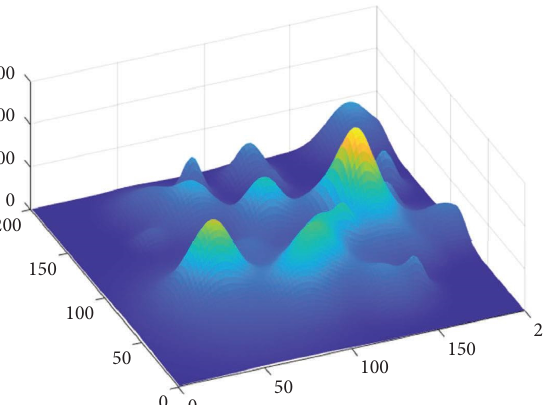
Figure 1: Seamount model